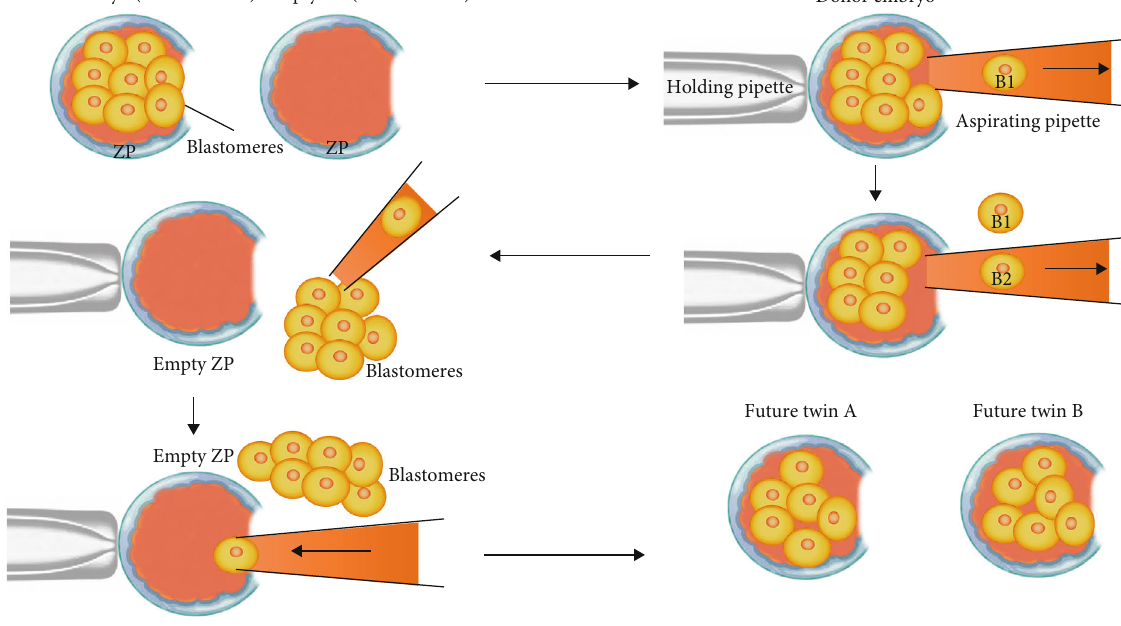
Figure 5: Blastomere biopsy/separation stages. B: